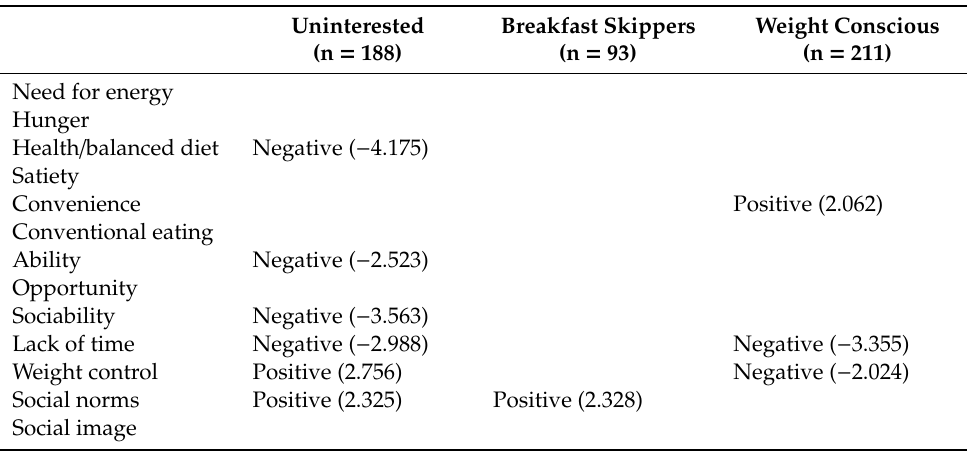
Table 6. Summary of associations between healthfulness of eating habits score and motivations across the